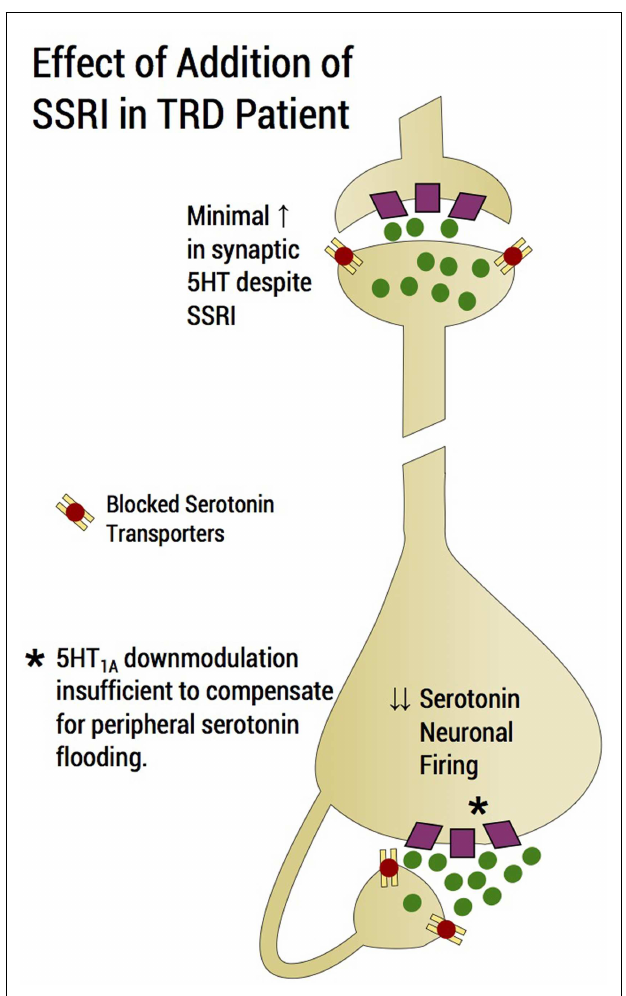
FIGURE 3 | Effect of addition of an SSRI in aTRD patient . SSRI addition would induce a flood of serotonin in the region of the dorsal raphe and would tend to shut down serotonin neuronal firing through agonism of 5-HT 1A autoreceptors and would tend to exacerbate rather than improve a deficit state of serotonin at the distal projection site. Raising the dose of the SSRI, which is common practice in an upward titration strategy, may in fact, exacerbate the situation of flooding the extracellular fluid with serotonin and further preventing the possibility of serotonin neurotransmission enhancement.The serotonin system may impervious to the physiological process of an increment of SSRI producing a commensurate enhancement of serotonin neurotransmission. Rather, an increment in SSRI reduces the likelihood of serotonergic neurotransmission enhancement as the dosage increase exacerbates the build-up of serotonin in the peri-raphe area,